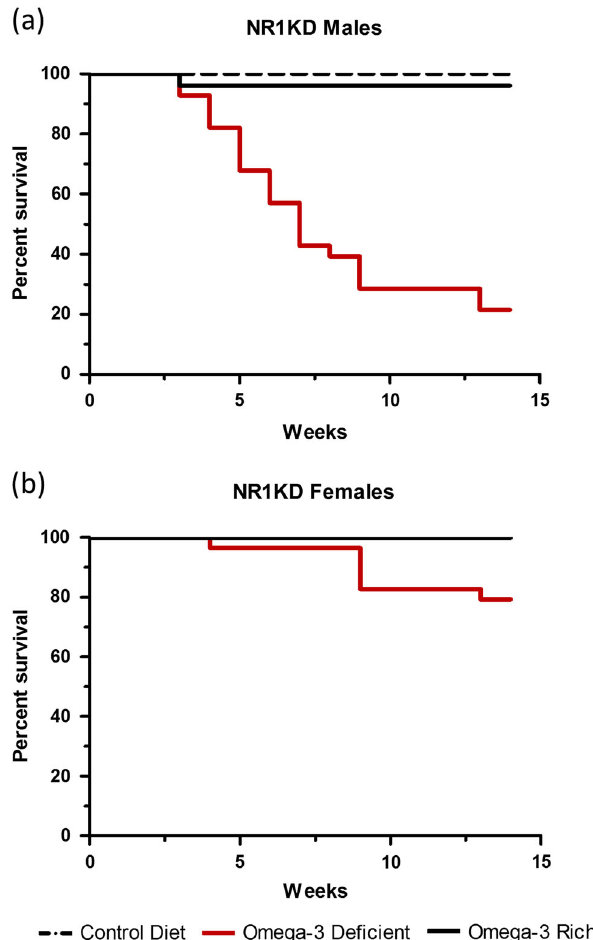
Fig. 1 Kaplan – Meier survival curve for male and female NR1KD mice in three diets. a Survival curve for NR1KD males on control, omega- 3-rich and de fi cient diets, aged 3 – 15 weeks. At 15 weeks, 21% of male NR1KD mice survived until the end of the study on the omega- 3-de fi cient diet ( X (2) = 49.01; p < 0.0001, n = 19 – 25 mice per group). Control diet and omega-3-rich diets did not affect survival of NR1KD mice ( p = 0.39). b Survival curve for NR1KD females on control, omega-3-rich and de fi cient diets, aged 3 – 15 weeks. All females on the control diet and omega-3-rich diets survived until testing end point ( p = 1.0). By the end of the study, 80% of female NR1KD mice survived on the omega-3-de fi cient diet ( X (2) = 10.70; p < 0.005, n = 23 – 25 mice per